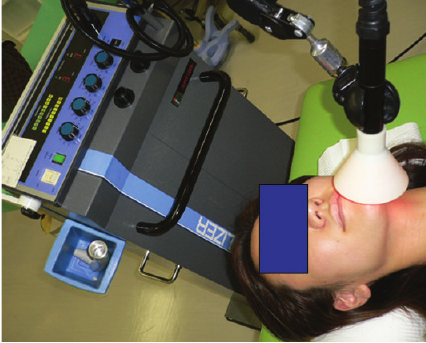
Figure 14: Near-infrared